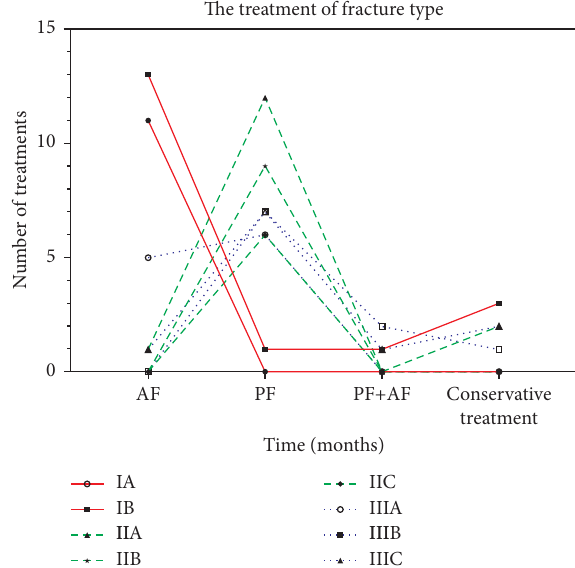
Figure 3: Statistics of fracture types and treatment methods.